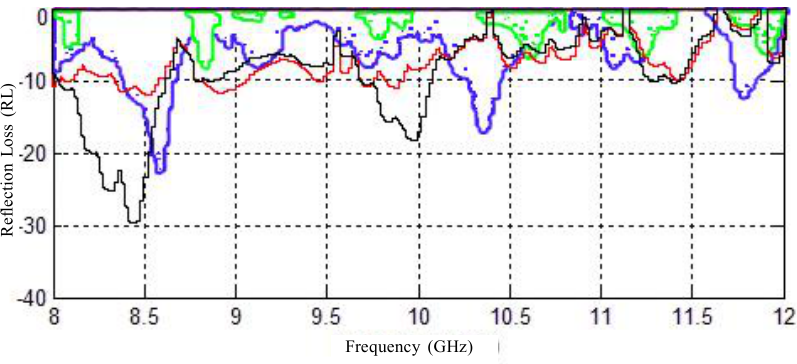
Frequency (GHz) Fig. 6. The variations of RL versus frequency in the range of 8-12 GHz for A1 (green), A2